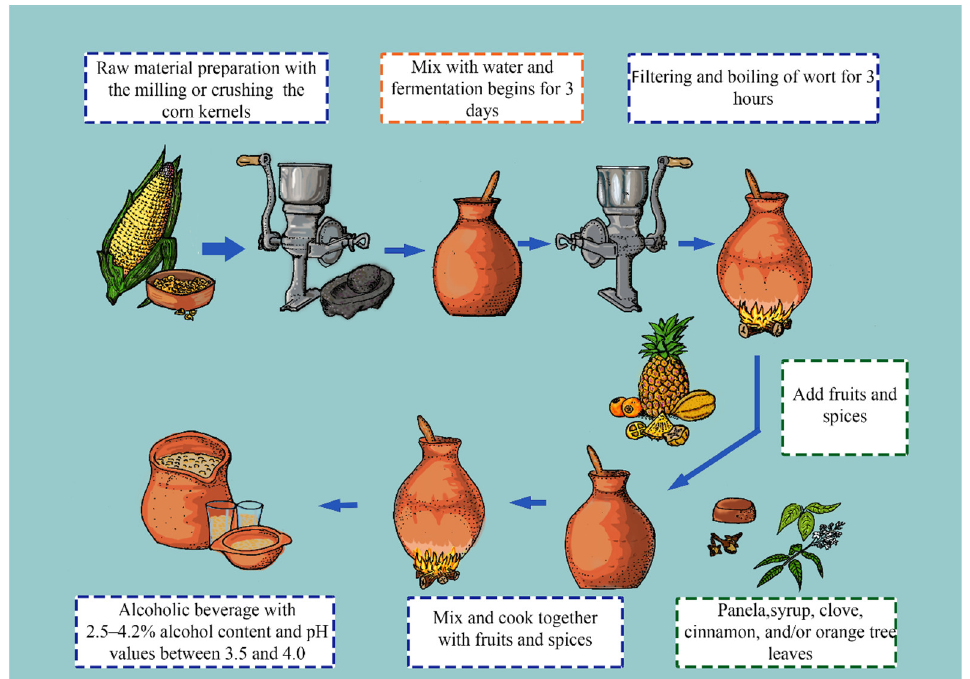
Figure 2. Flow diagram depicting the champús brewing process, considered as the indigenous An- dean beer. Andean